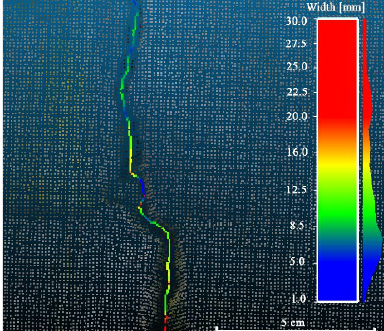
Figure 8 . 3D crack skeleton reconstructed by the ray-plane intersection method. For each skeleton point, the colorscale represents the crack width computed as the 3D Euclidean distance between the closest edge